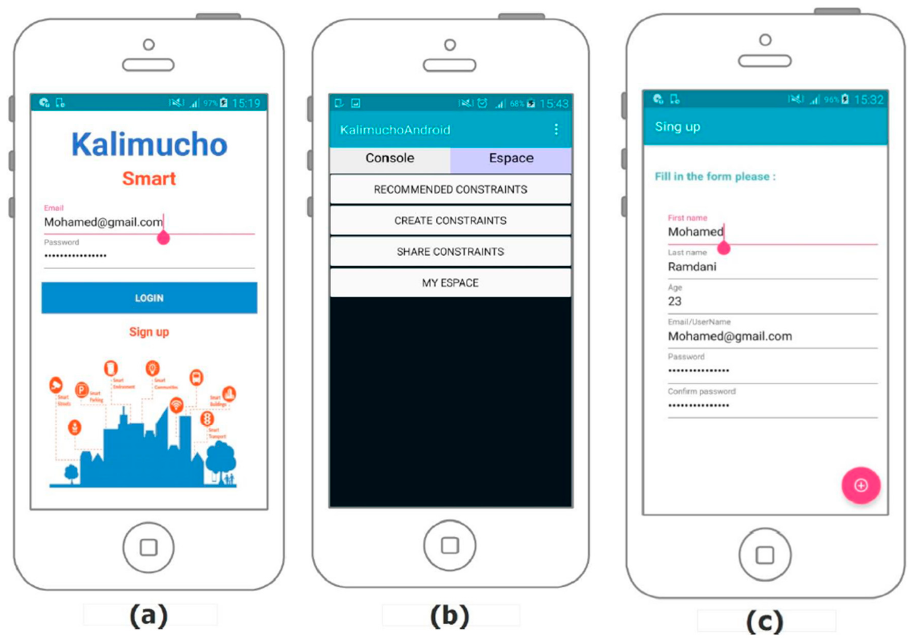
Figure 16. Screenshots of the Kali ‐ Smart platform ( a ) authentication, ( b ) my space, ( c ) new account.